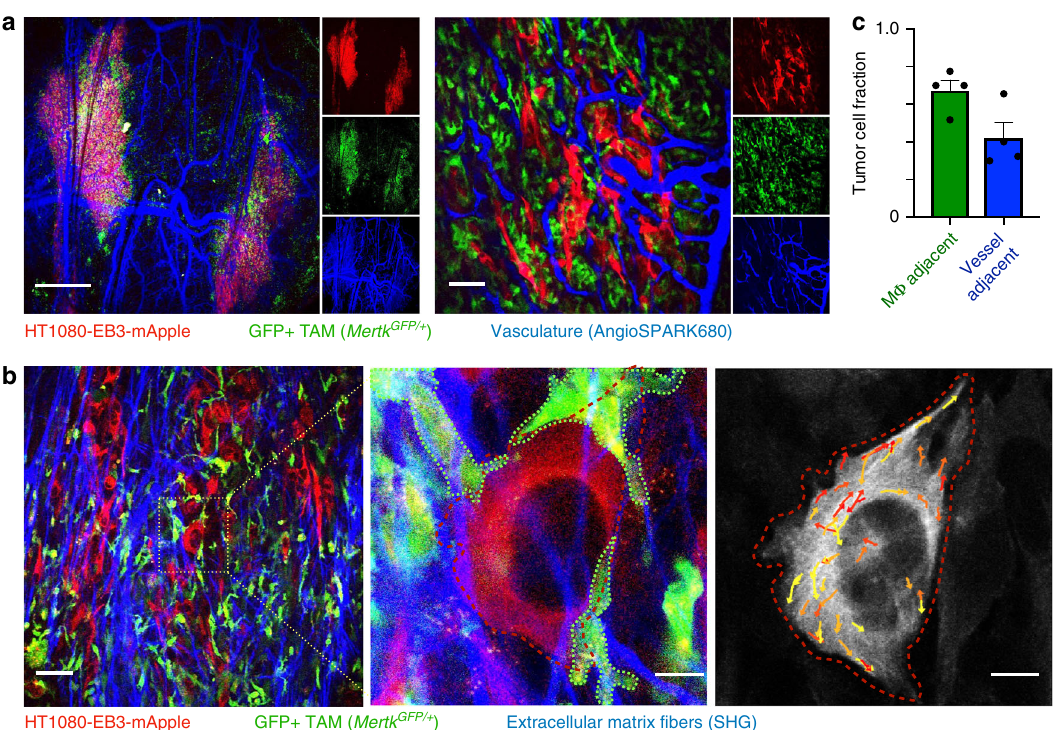
Fig. 3 TAMs frequently neighbor tumor cells near vasculature and fi brillar extracellular matrix. a , b Representative IVM of HT1080 tumors grown subcutaneously in the dorsal window chamber of Mertk GFP/ + NOD.SCID mice at low (left) and high (right) magni fi cations. a A long-circulating fl uorescent NP, angiospark-680, and b 2-photon microscopy of second harmonic generation, SHG show tumor vasculature and fi brillar extracellular matrix, respectively. At bottom right, EB3 tracks are shown randomly pseudo-colored for visualization. Scale bars are 1 mm ( a , right), 50 μ m ( a , b , left), and 10 μ m ( b , right). c Corresponding to images as in ( a ), tumor cells were scored based on nearest proximity (<5 μ m) to GFP + TAMs or AngioSPARK + vasculature (data are means ± s.e.m.). For all, n = 80 total cells and n = 4 tumors overlaid as individual data points in ( c ). Source data are provided as a source data fi